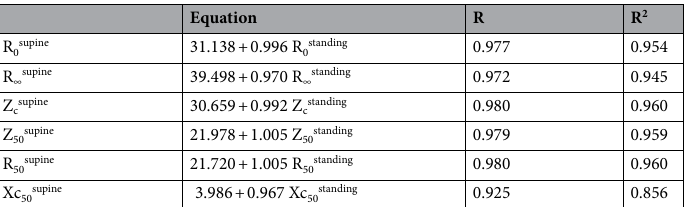
Table 4. Regression equations developed in development sub-group (n = 35) to allow measurements obtained when standing (≥ 4 min) to be comparable to those obtained when supine. R 0 resistance at 0 kHz, R ∞ resistance at infinite kHz, Z c impedance at the characteristic frequency, Z 50 impedance at 50 kHz, R 50 resistance at 50 kHz, Xc 50 reactance at 50 kHz.